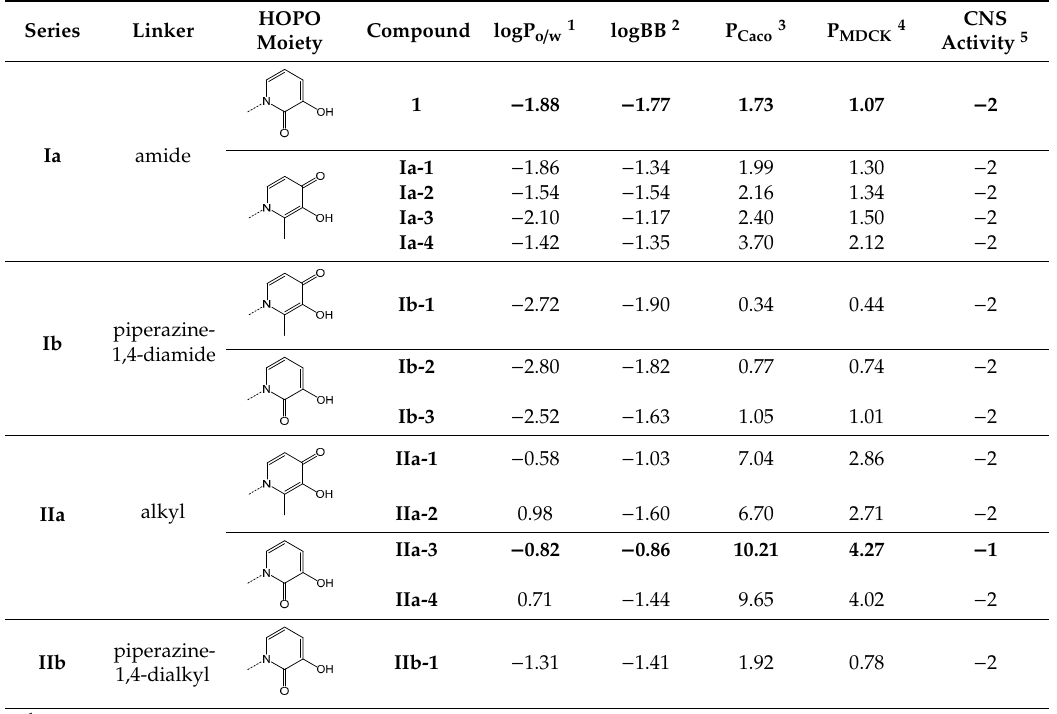
1 P o/w represent the octanol/water partition coefficient. QikProp ‐ recommended values for logP o/w are ranged from − 2 to 6.5. 2 BB represent the brain/blood partition coefficient for orally delivered drugs.